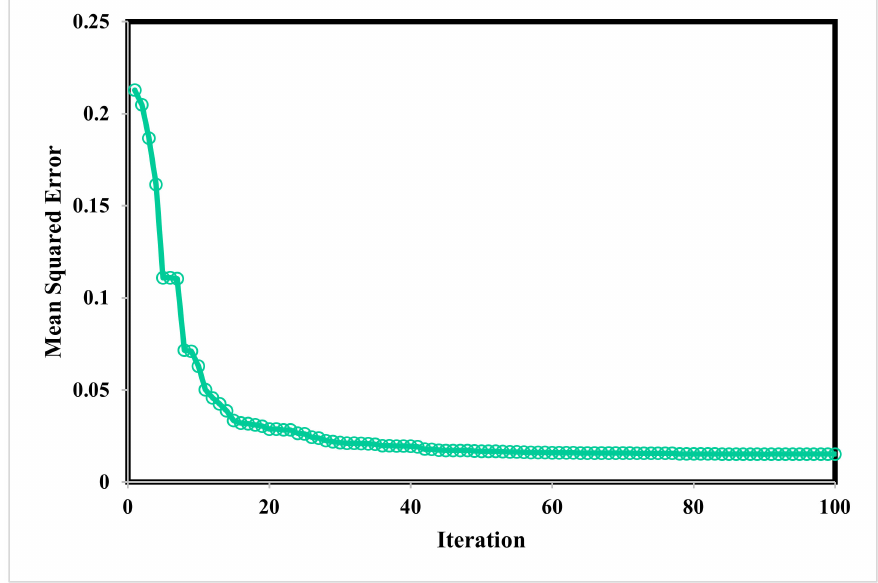
Figure 3. The performance of the LM algorithm according to the MSE of di ff erent iterations for the radial basis function